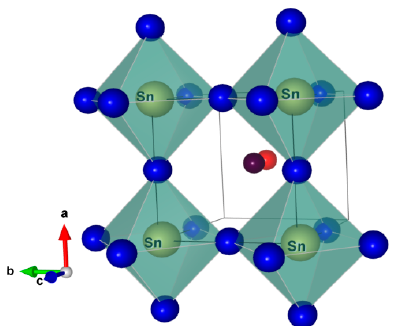
Figure 1. Building Block of α -CH 3 NH 3 SnI 3 [47] (COD Id = 4335632), Color code: I = Blue, Sn = Yellow, C = Red, N = Purple. Energies 2021 , 14 , x FOR PEER REVIEW Table 1. Simulation parameters for perovskite solar cell using SCAPS ‐ 1D.